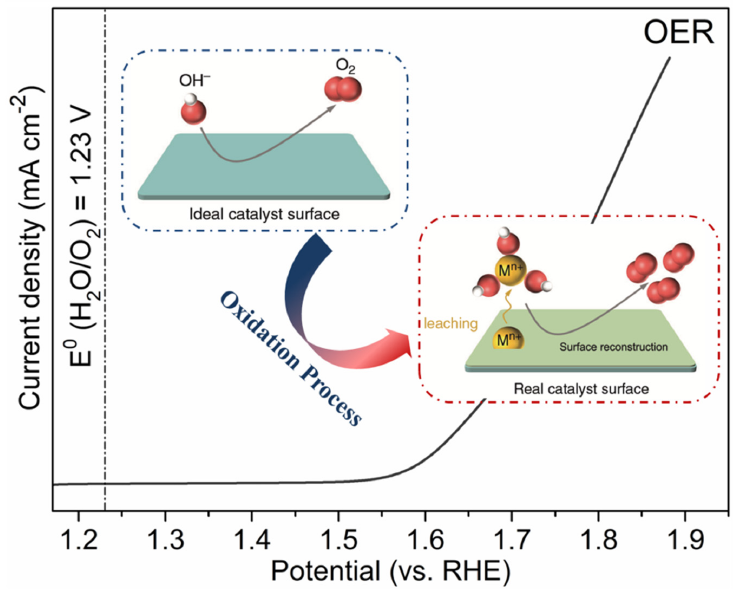
Figure 2. Schematic of the polarization curves of the OER and schematic illustration of the